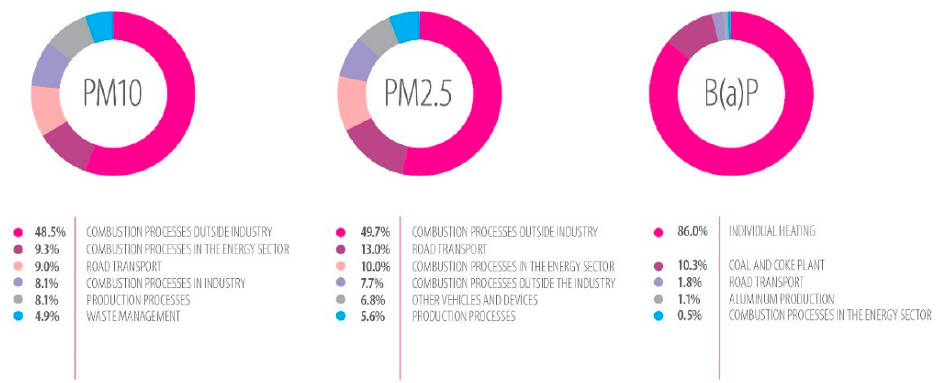
Figure 1. Sectors responsible for particulate matter (PM)10, PM2.5 and benzo(a)pyrene emissions in Poland (based on Reference [27]).